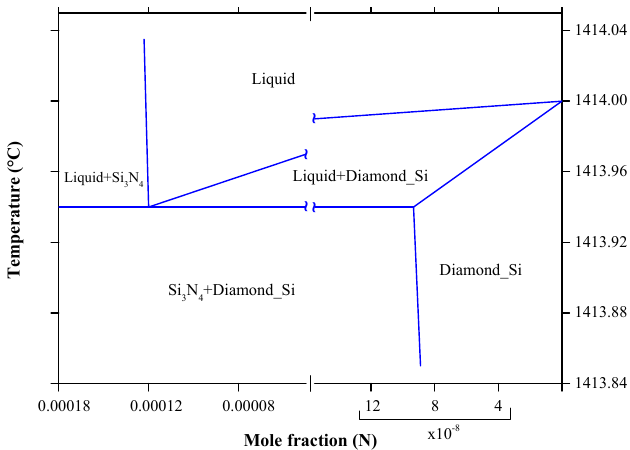
: [221]; (cid:3) : [223]. (cid:35)